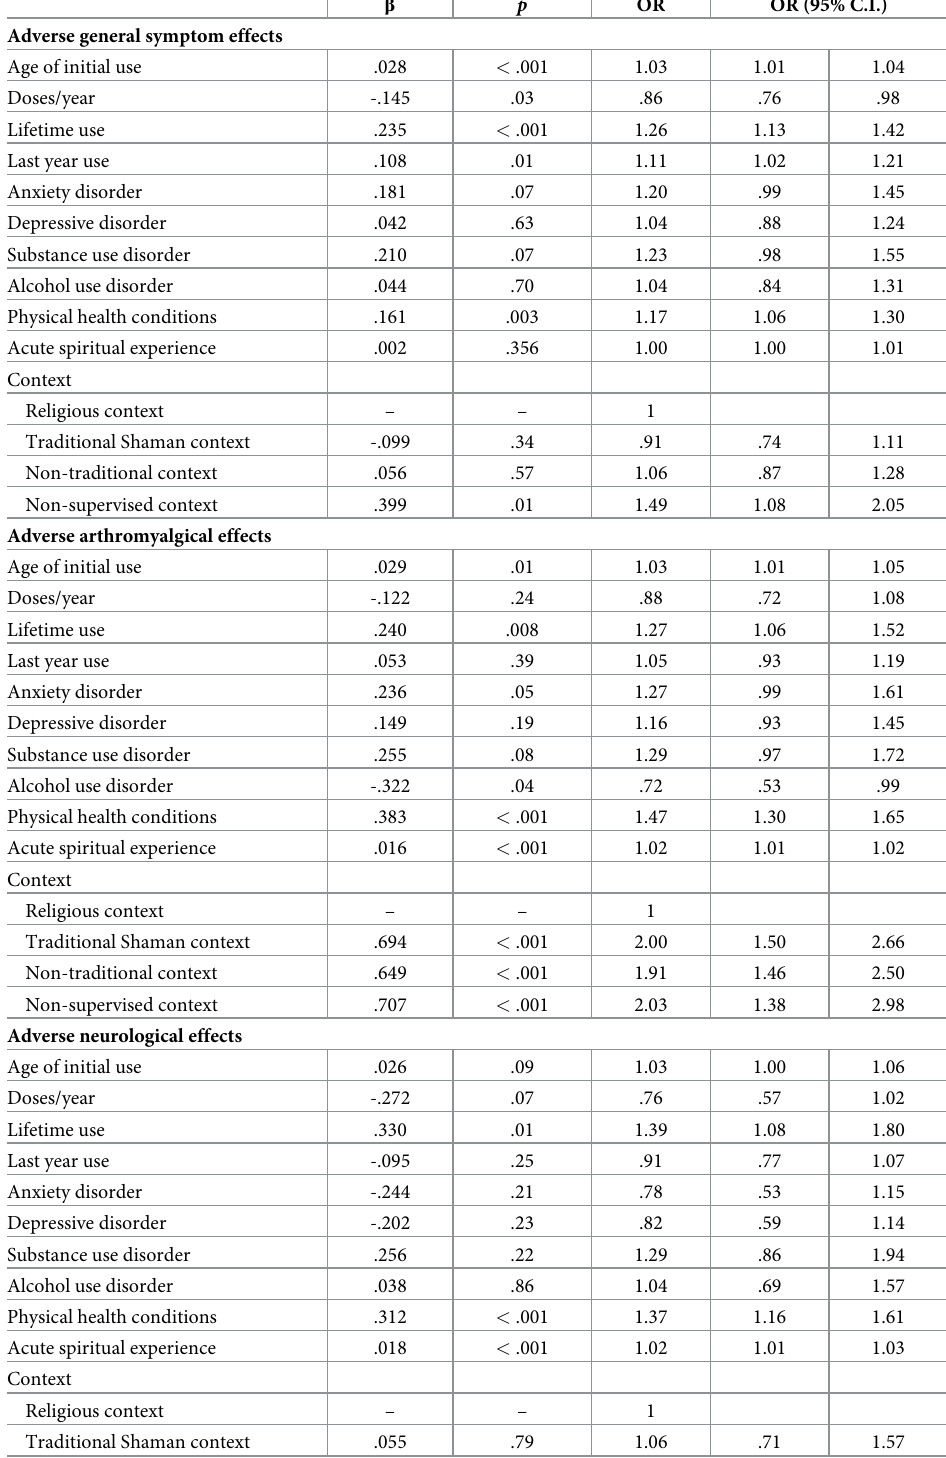
Table 5. History of ayahuasca use and medical status variables’ relationship with the presence of adverse physical effects for each